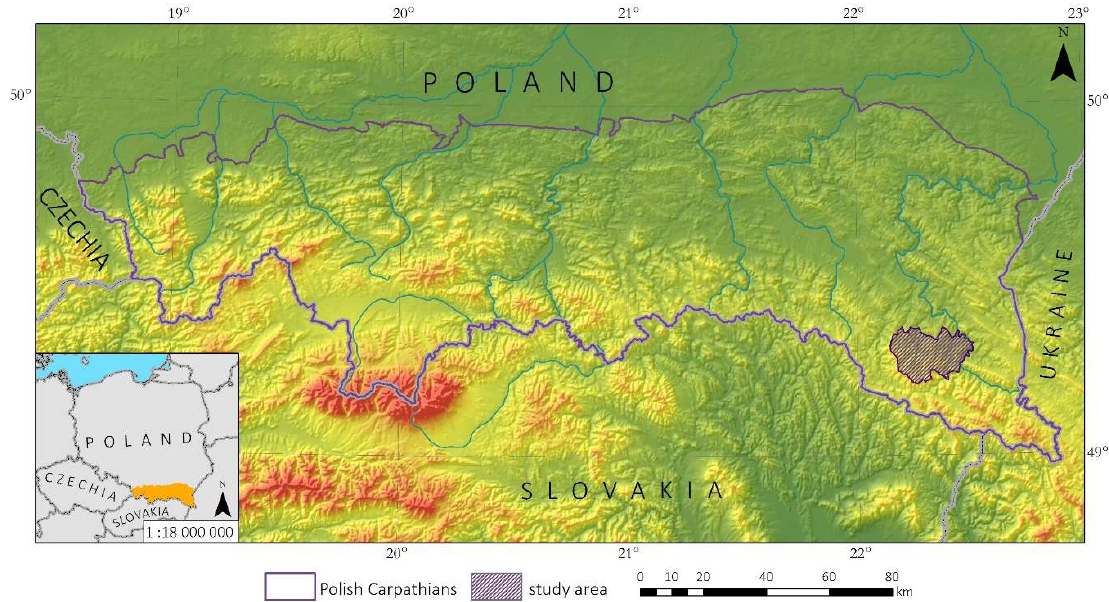
Figure 1 . The test area located in the Baligród Forest District in the Polish Carpathians. Figure 1. The test area located in the Baligr ó d Forest District in the Polish